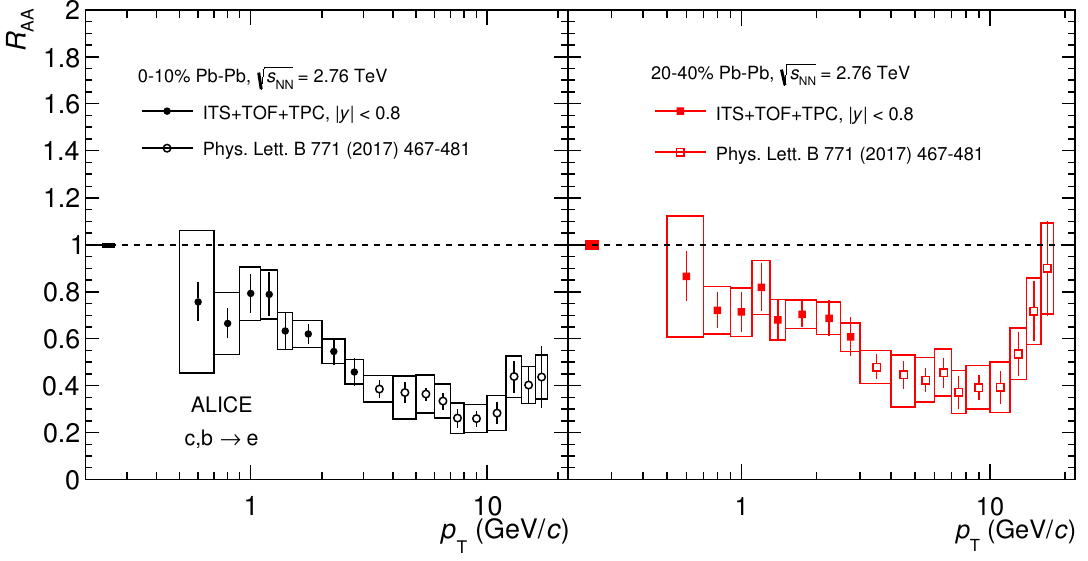
Figure 3 . Nuclear modi(cid:12)cation factor R AA for electrons from semileptonic heavy-(cid:13)avour hadron decays at mid-rapidity as a function of p T in 0{10% (left panel) and 20{40% central (right panel) Pb{ p Pb collisions at s NN = 2 : 76 TeV. Error bars (open boxes) represent the statistical (systematic) uncertainties. The normalization uncertainties are represented by the boxes at R AA = 1. The previously published results from [42] have been updated using a new glauber model calculation